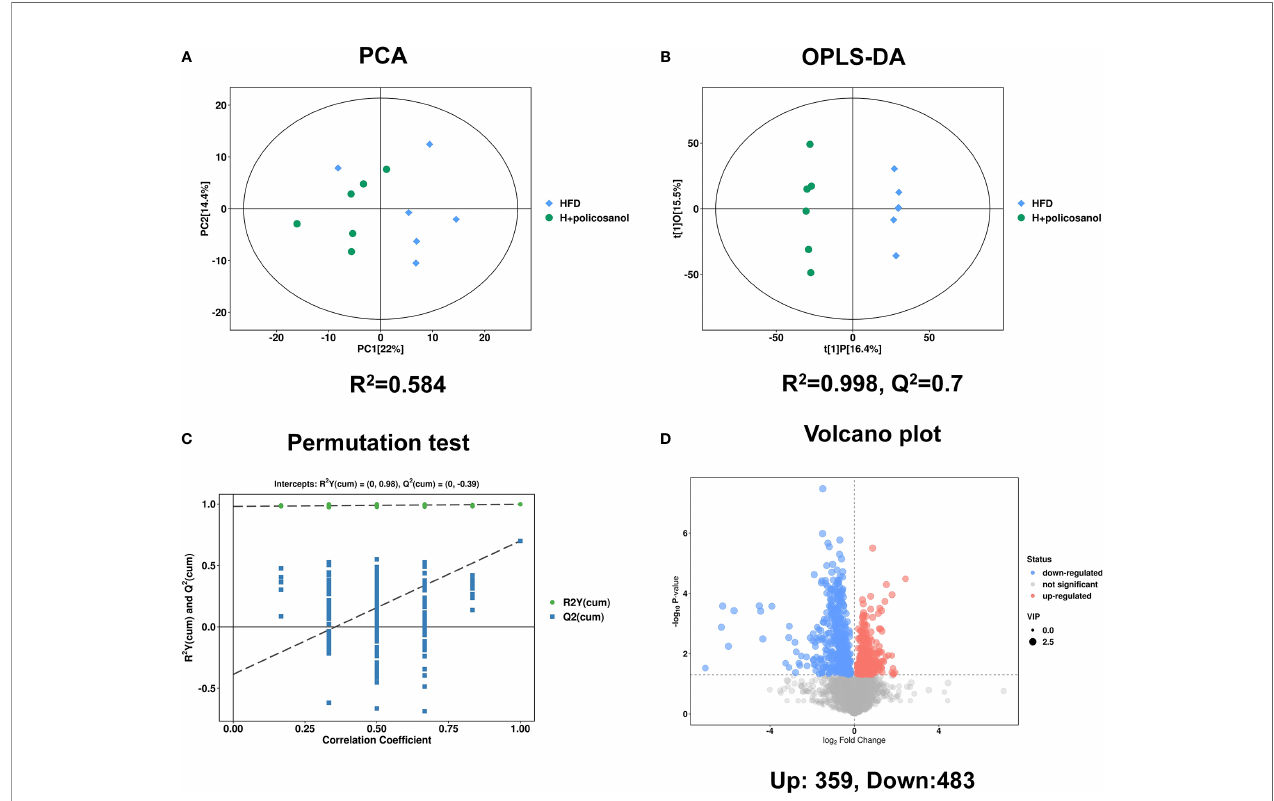
FIGURE 4 | Policosanol affects the metabolites in mice. (A) The principal component analysis plot based on the metabolites matrix in the serum. (B) The orthogonal partial least squares discrimination analysis (OPLS-DA) plot based on the metabolites matrix in the serum, (C) permutation test plot based on OPLS-DA methods. (D) The volcano plot based on the changed metabolites the HFD group compared to the HFD+policosanol group.